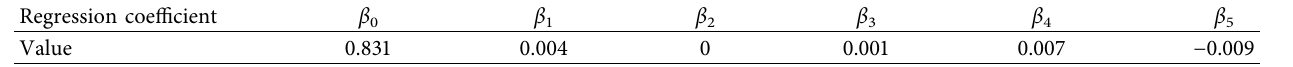
Table 8: Table of regression coefficients for each